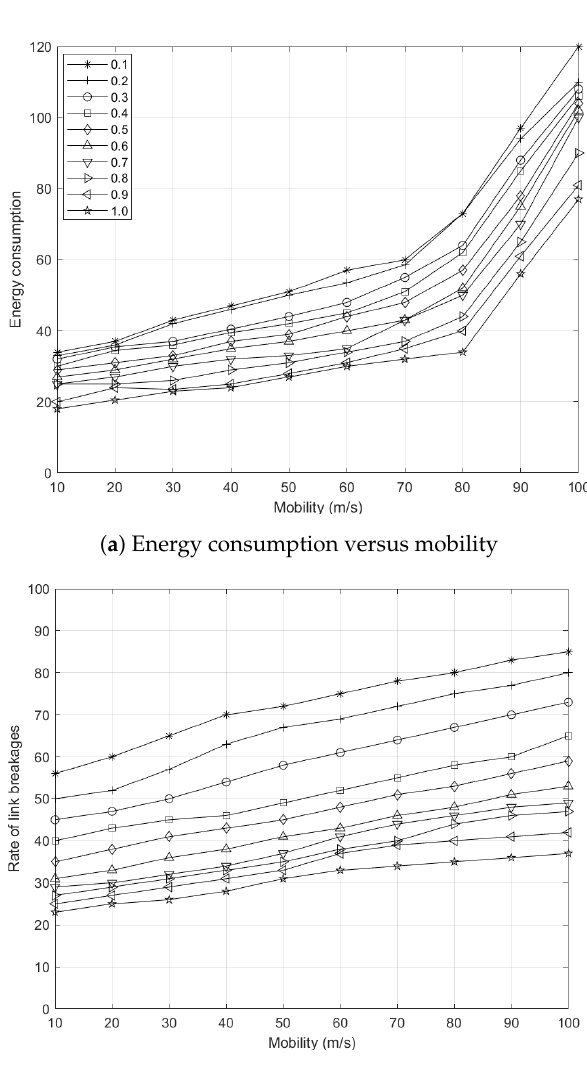
Figure 4. Graphical results for the effects of network density on RL. Learning rate α = 1.0 achieves the lowest energy consumption and rate of link breakages, as well as the highest network lifetime.